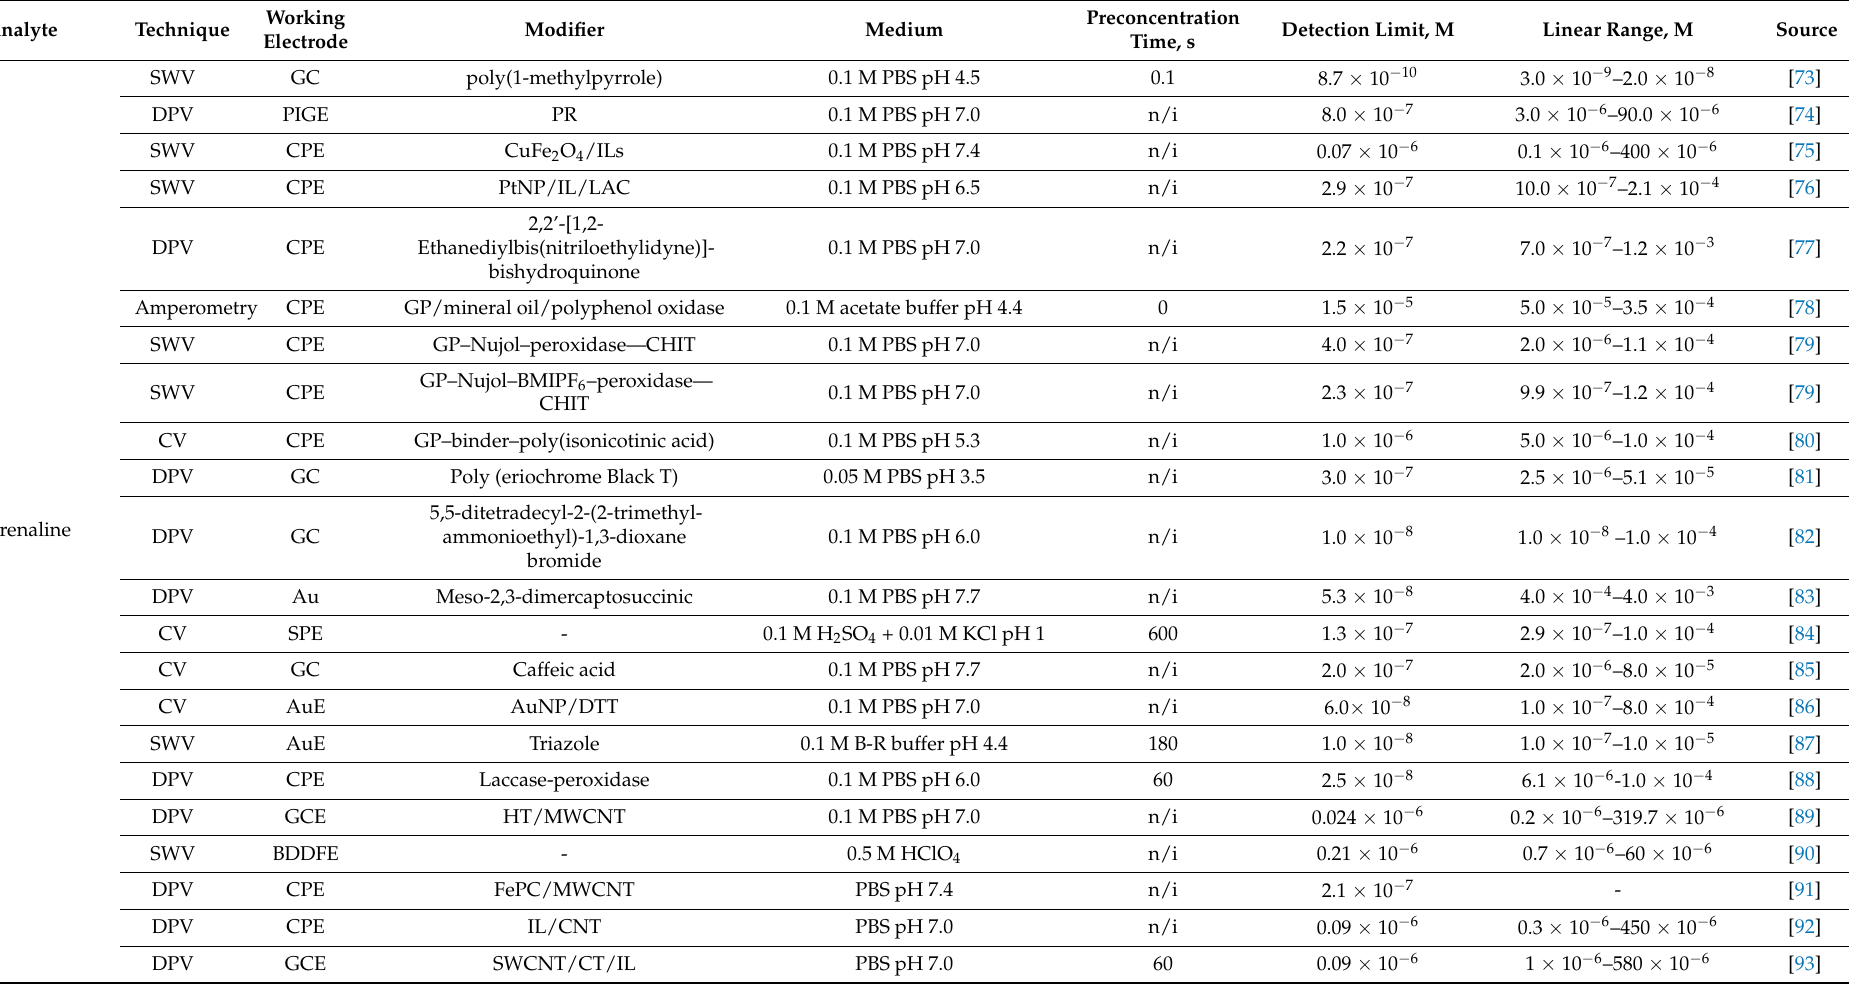
Table 2. Electrochemical methods of adrenal gland hormones